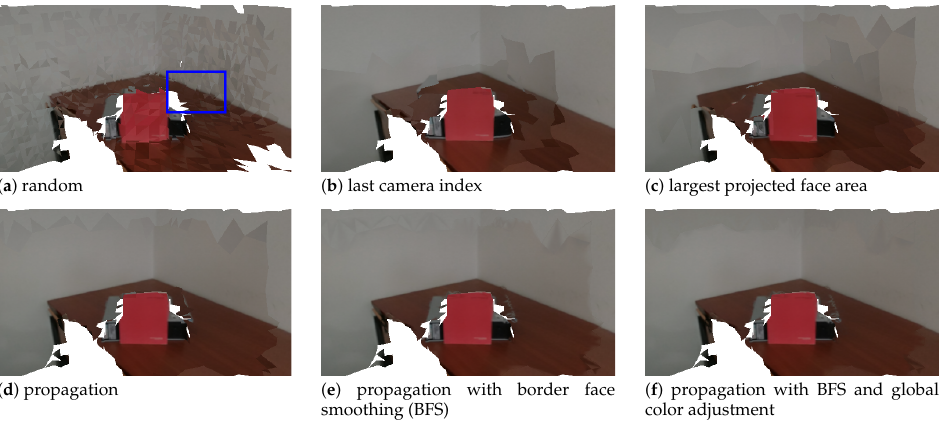
Figure 14. Textured meshes obtained using distinct camera selection approaches, as well as border face smoothing and global color adjustment additional